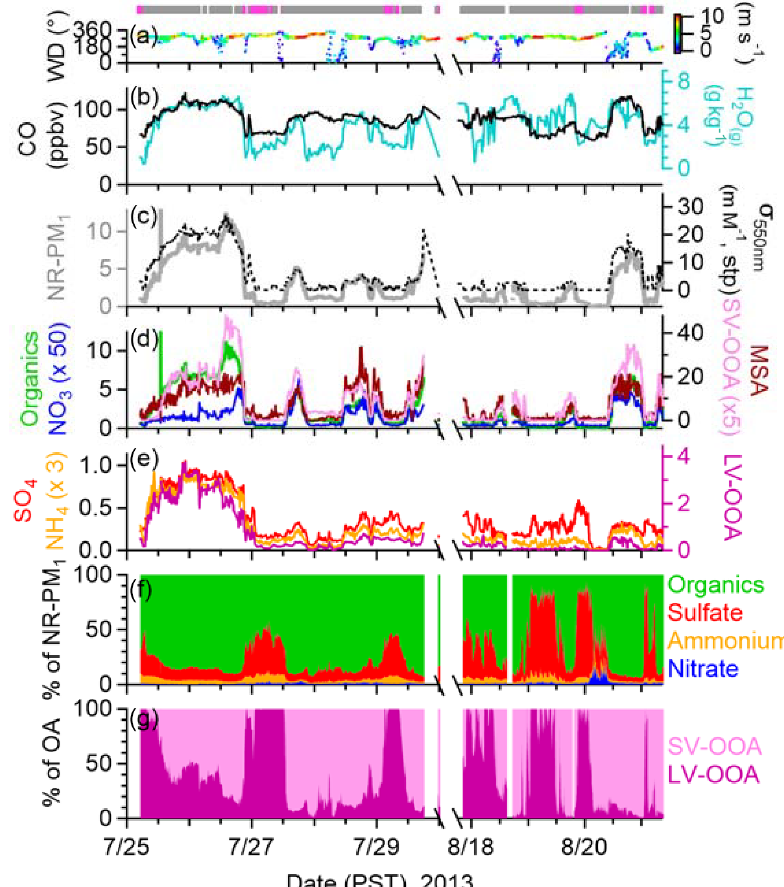
Figure 1. Observations during two clean periods in summer 2013. Time series of (a) wind direction (WD) colored by wind speed (ms − 1 ); (b) mixing ratios of CO and water vapor (H 2 O ( g ) ); (c–e) mass concentrations of NR-PM 1 species, OA factors (µgm − 3 ) and MSA (ngm − 3 ) at ambient conditions, and submicron aerosol light scattering at 550nm ( σ 550 nm ); (f) NR-PM 1 composition; and (g) OA composition. The indicator bars at the top of the graph are colored by air mass types: free troposphere (pink) and boundary layer influenced